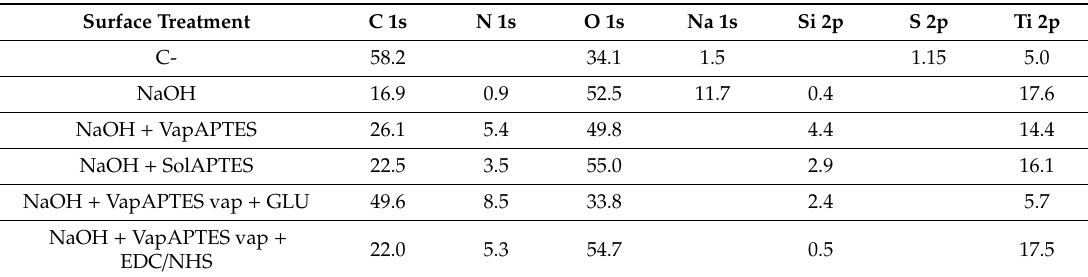
Figure 3. Surface compositional analysis of Ti-6Al-4V disks subjected to different surface treatments: ( a ) untreated control, ( b ) after etching (NaOH), ( c ) after etching and silanization by vapour deposition (NaOH + VapAPTES), ( d ) after etching and silanization by solvent deposition (NaOH + SolAPTES). Sodium (Na) and oxygen (O) are introduced by the etching phase and Silicon (Si) by silanization phase. Energy dispersive spectroscopy. Primary electron beam energy was set to 15 KeV. Spectra are collected over an area of 25 µm 2 . Integration time 200 s. Table1. Surfaceatomicpercentagesonsamplesatdi ff erentstepsoftheproductionprocess. Composition was obtained for the most relevant elements identified by